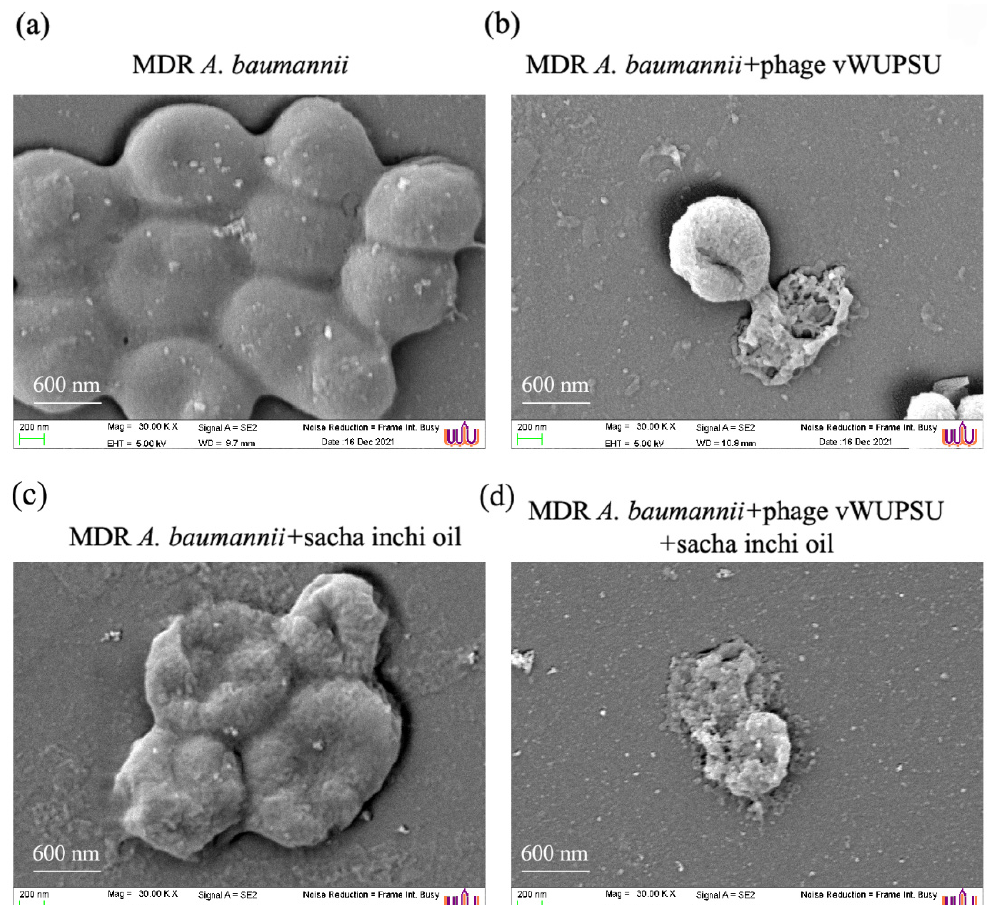
Figure 9. Ultrastructural analysis of MDR A. baumannii cells after treatments. MDR A. baumannii cells were incubated with ( a ) only TSB, ( b ) phage vWUPSU at an MOI of 1, ( c ) sacha inchi oil at 0.5 × MIC, and ( d ) the combined phage vWUPSU and sacha inchi oil for 3 h. Then, the cells were collected, fixed, dehydrated, and observed under a field emission scanning electron microscope at an acceleration voltage of 5 kV (30,000 × magnification). The scale bar represents 600 nm.